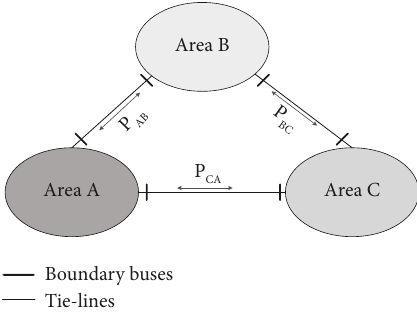
Figure 1: Three-area power